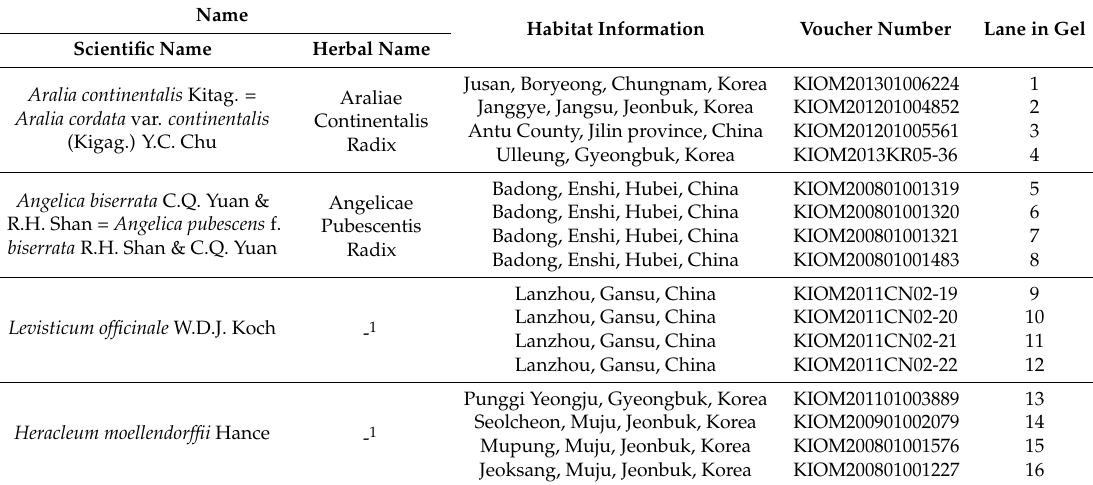
Table 1. Plant materials used in this study.